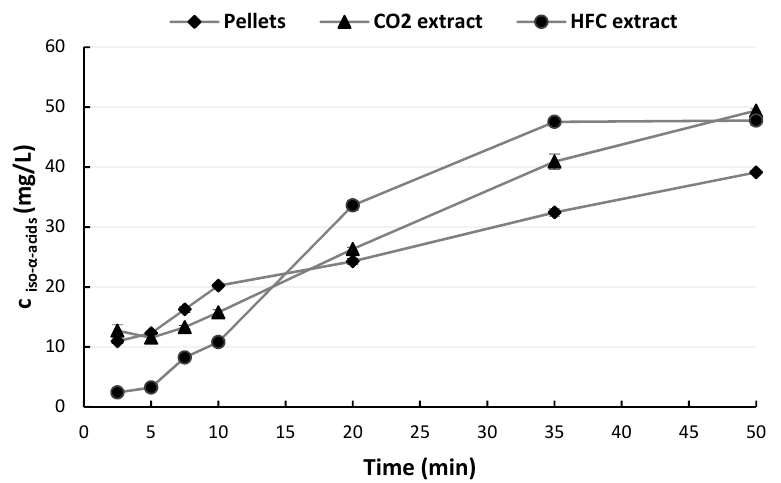
Figure 4. Total iso- α -acids concentration (c iso- α -acids ) evaluated during 50 min boiling when pellets, CO 2 extract, or HFC extract were added to the wort during laboratory-scale isomerization trials. During the first 15 min of process, a higher increase in total iso- α -acids concentration (c iso- α -acids ) was observed when pellets and CO 2 extracts were added into the boiling wort (trials I1 and I2, respectively) in comparison with the iso- α -acid amount determined by adding HFC extract.